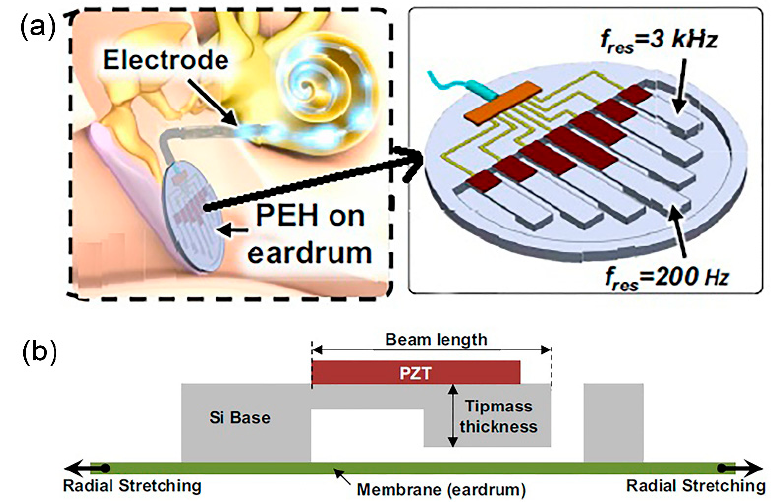
Figure 26. ( a ) The proposed piezoelectric cantilevers placement on the tympanic membrane ( b ) the bulk piezoelectric cantilever on the eardrum membrane model. © 2013 IEEE. Reprinted, with permission, from [90].